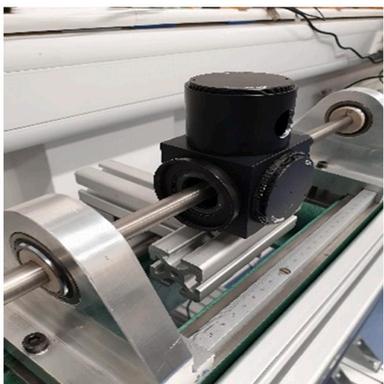
Bespoke fixture for the SHPB to contain the sample for low temperature, high rate experiments.